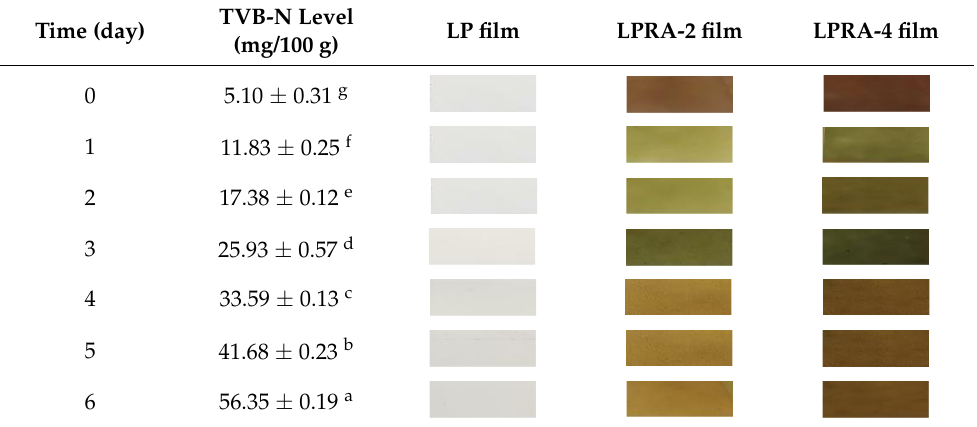
Figure 8. Color changes ( A ) and UV/Vis ( B ) spectra of RA in pH 3 – 12 buffers, and the color changes of LP film, LPRA-2 film, and LPRA-4 film in pH 3 – 12 buffers ( C ) and ammonia gas ( D ).